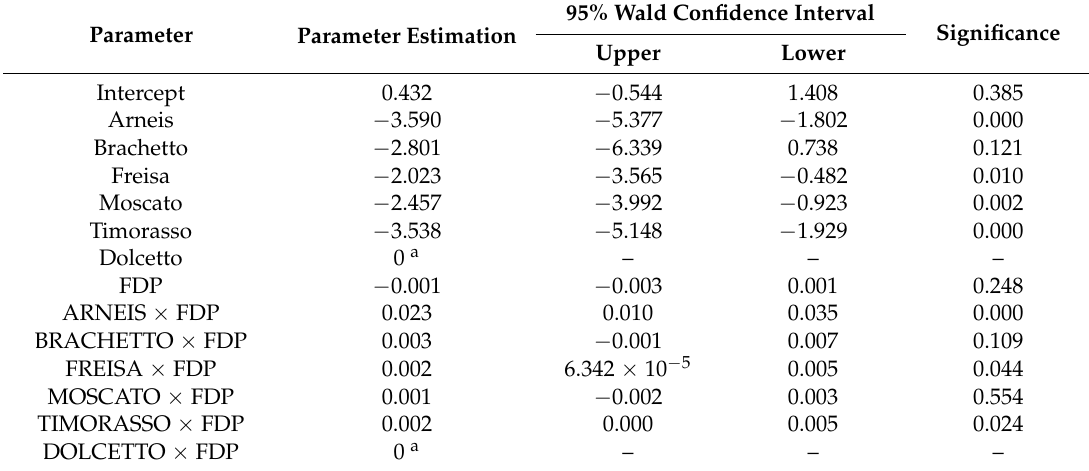
Table 3. Parameter estimation of the Generalized Linear Model Analysis. Model: (intercept), Variety, plant DNA; Events: acquisition